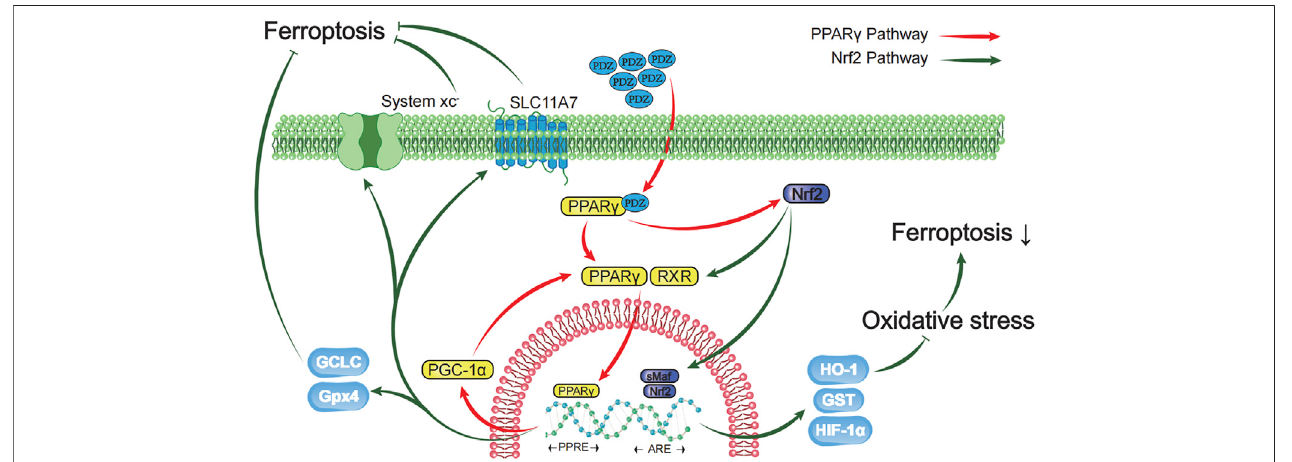
FIGURE 7 | Schematic diagram showing that activation of the PPAR- γ pathway prevents ferroptosis-induced neuronal loss in an intracerebral hemorrhage model throughsynergisticactionswiththeNrf2pathway.Pioglitazone,aPPAR γ agonist,inhibitedtheiron-induceddeathofneuronsafterICHbyactivatingthePPAR γ pathway and promoting the expression of Gpx4, HIF-1 α , HO-1, GST and SLC11A7 through the interaction between PPAR γ and the Nrf2 pathway. The green arrow represents the Nrf2 pathway, and the red arrow represents the PPAR γ